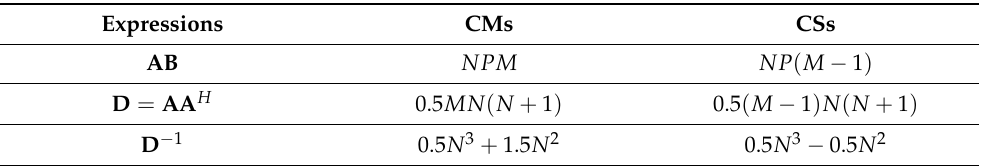
Table 1. Computational complexity of complex multiplications and complex summations in three matrix-related